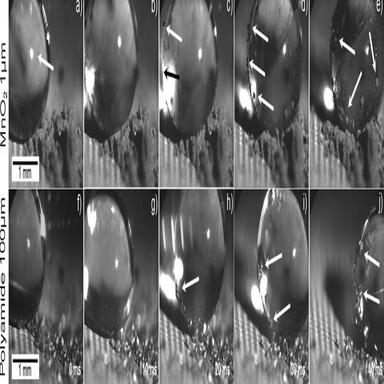
Extracts from high-speed videos on a 7 µm DLIP structured sample tilted 15°. The surface was covered with 1 µm MnO2 (a–e) and 100 µm polyamide particles (f–j). The time frame for each sequence is 40 ms. Arrows indicate the particles adsorbed by the 10 µl deionized water droplet.